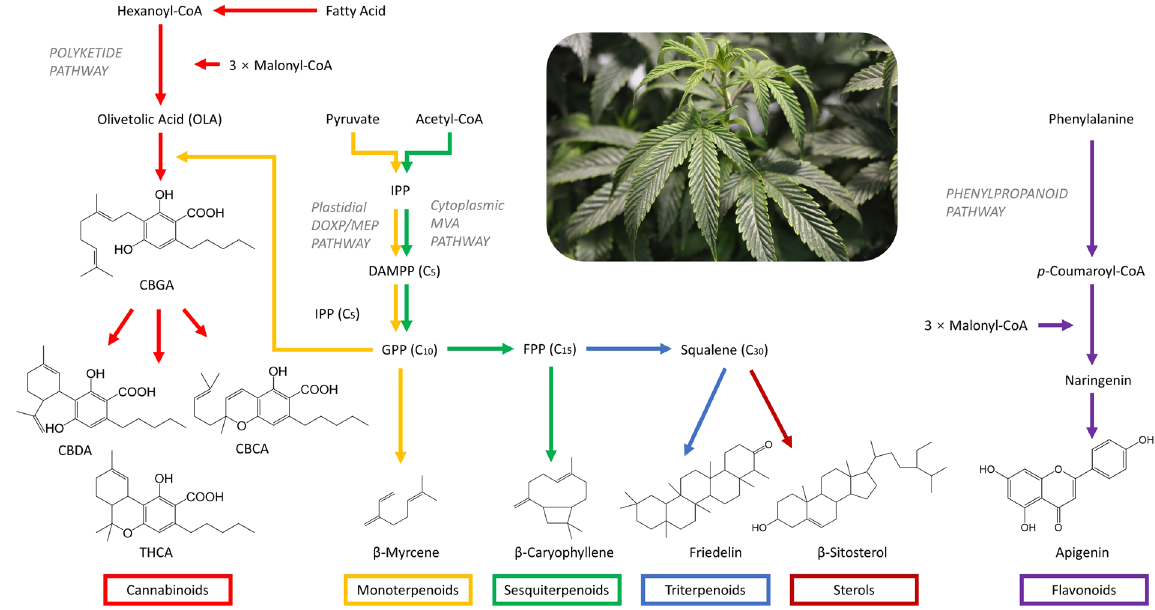
Figure 1. Biosynthesis pathways of cannabinoid, terpenoids, sterols, and flavonoids 7,8 . Cannabinoids and terpenoids are produced and stored in the secretory cells of glandular trichomes, which are found in the aerial parts of cannabis plants and are especially dense on the top surfaces of seedless female flowers 38 . Two precursors for cannabinoids are olivetolic acid (OLA), derived from the polyketide pathway, and geranyl diphosphate (GPP), derived from the plastidial deoxyxylulose phosphate/methyl-erythritol phosphate (DOXP/MEP pathway) 102–104 . Cannabigerolic acid (CBGA) is formed by the condensation of OLA and GPP and is further converted to cannabidiolic acid (CBDA), ∆ 9 -tetrahydrocannabinolic acid ( ∆ 9 -THCA), and cannabichromenic acid (CBCA) by CBDA synthase 105 , ∆ 9 -THCA synthase 106 , and CBCA synthase 107 , respectively. If divarinic acid is condensed with GPP instead of OLA, the propyl (C 3 side-chain) instead of pentyl (C 5 side-chain) cannabigerovarinic acid (CBGVA) is produced, which can be further converted to cannabidivarinic acid (CBDVA), tetrahydrocannabivarinic acid (THCVA), and cannabichromevarinic acid (CBCVA) following similar pathways 53 . Terpenoids are derived from the mevalonate (MVA) pathway or from the DOXP/MEP pathway. Both pathways produce isopentenyl diphosphate (IPP), which is further isomerized to dimethylallyl diphosphate (DMAPP), at their endpoints 53 . The DOXP/MEP pathway provides GPP to form monoterpenoids (C 10 ) while MVA pathway provides farnesyl diphosphate (FPP) for sesquiterpenoids (C 15 ) and squalene as precursors for triterpenoids (C 30 ) and sterols 53 . Flavonoids in cannabis, mainly flavones (luteolin, apigenin, orientin, vitexin, and isovitexin) and flavonols (quercetin and kaempferol), exist as free aglycones or as conjugated O -glycosides or C -glycosides 7,52,108,109 . The phenylpropanoid pathway produces p -coumaroyl- CoA from phenylalanine. In conjunction with three molecules of malonyl-CoA, p -coumaroyl-CoA produces naringenin, which is the substrate for flavone and flavonol biosynthesis 8,53